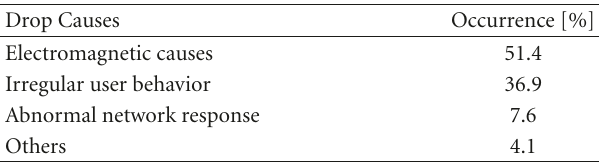
Table 1: Occurrence of call-dropping causes in a reference cell.